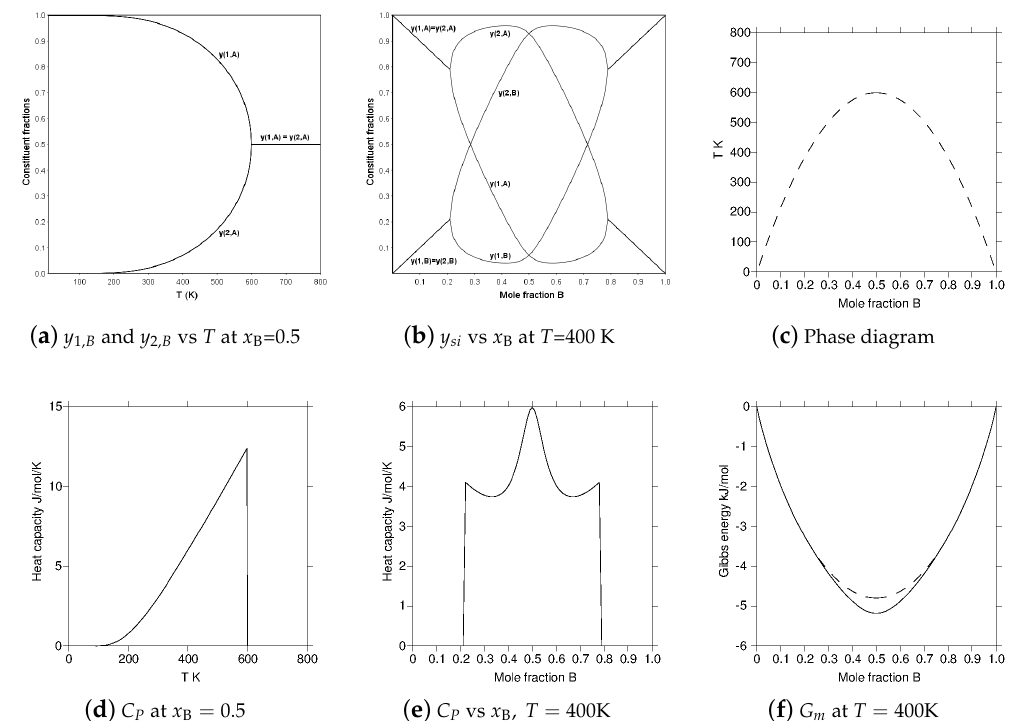
Figure 3. Some calculated diagrams for order–disorder transformations for a reciprocal model with a single bond energy and no short range ordering (SRO). The 2nd order transition is dashed in ( c ); the dashed curve in ( f ) is without long range ordering